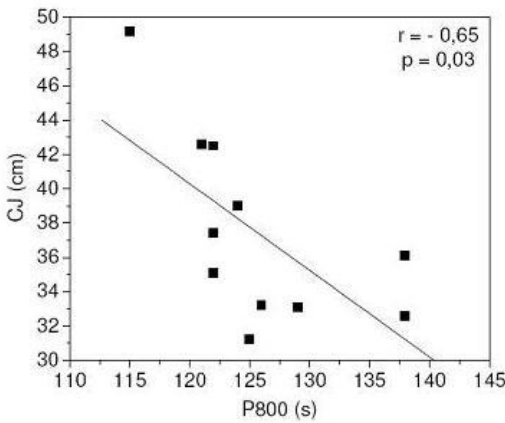
Figura 2 . Correlação do CJ com a performance na distância de 800 m.